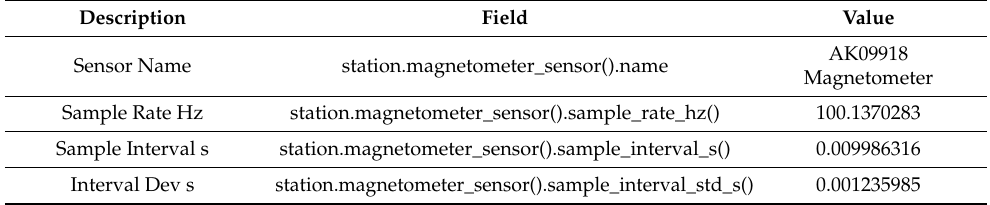
Table 9. Magnetometer